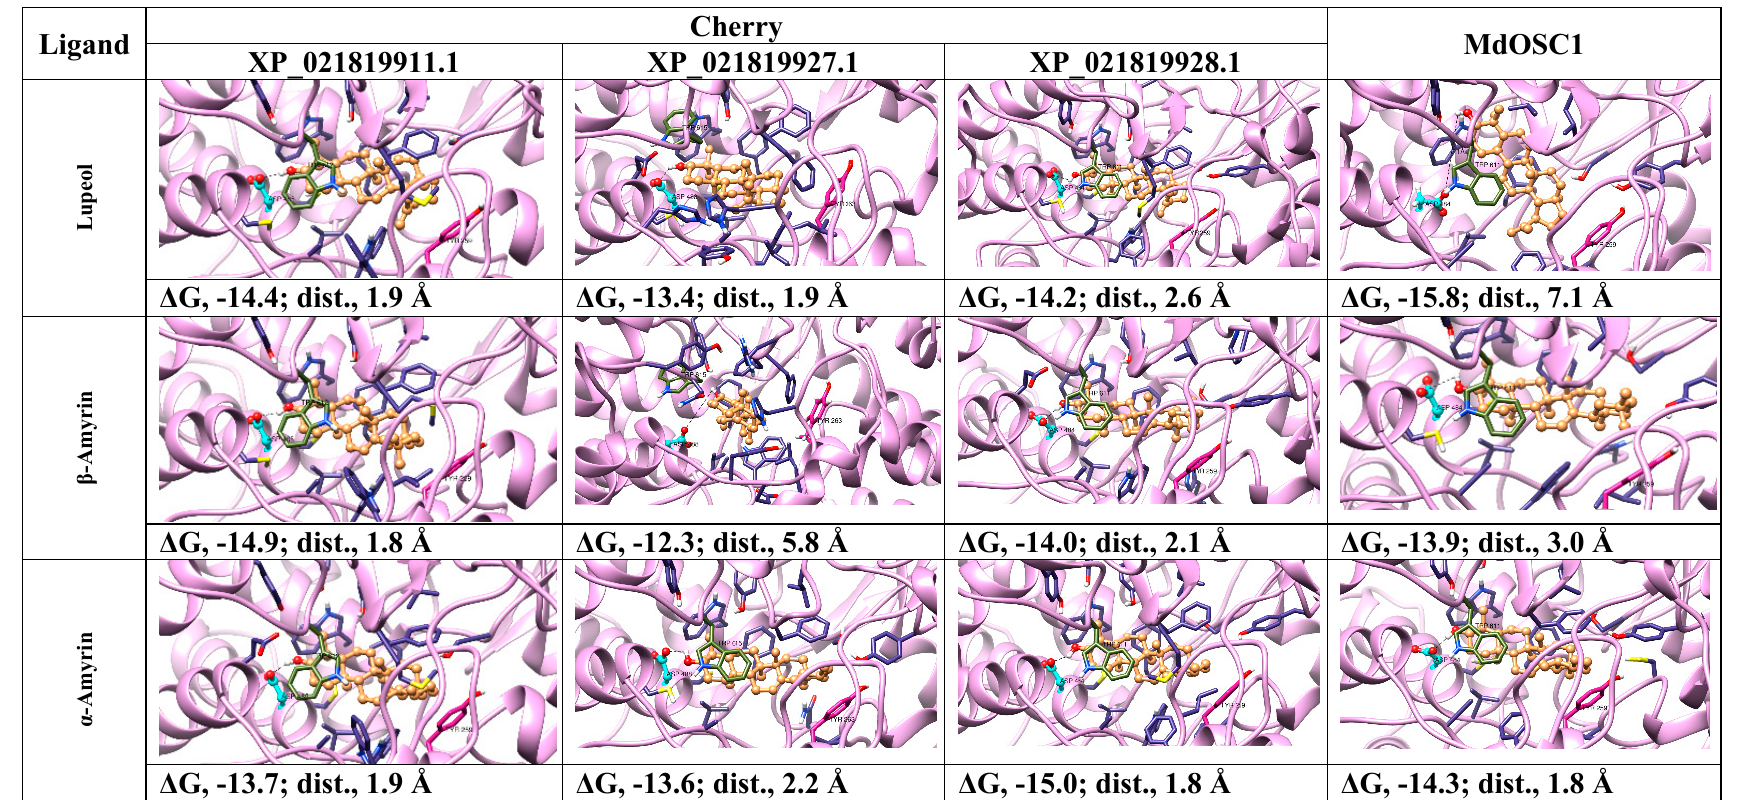
Figure 10. Poses, ligand ‐ OH ‐‐‐‐ OOC ‐ Asp ‐ protein distances and affinities of oxidosqualene cyclases (OSCs) docked with the reaction products from fruit models. Δ G, Gibbs free ‐ energy of binding (kcal mol − 1 ); dist, ligand ‐ OH.…OOC ‐ Asp ‐ protein distances. Ligand, brown; catalytic Asp, cyan; Trp docking reference, green; Tyr/His: magenta. Other active site residues, dark blue; oxygen atoms, red; nitrogen atom, light blue and hydrogens, white.